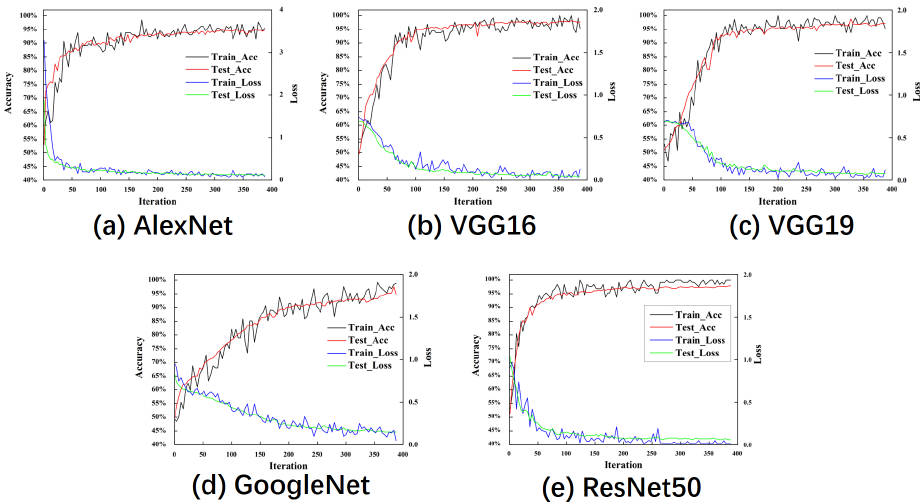
Figure 15. Change in accuracy and loss of five CNN